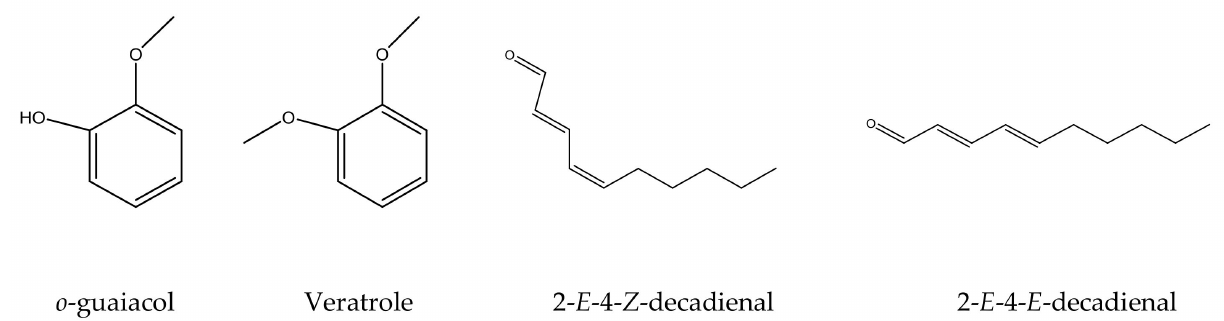
Figure 1. Chemical structures of the identified birch